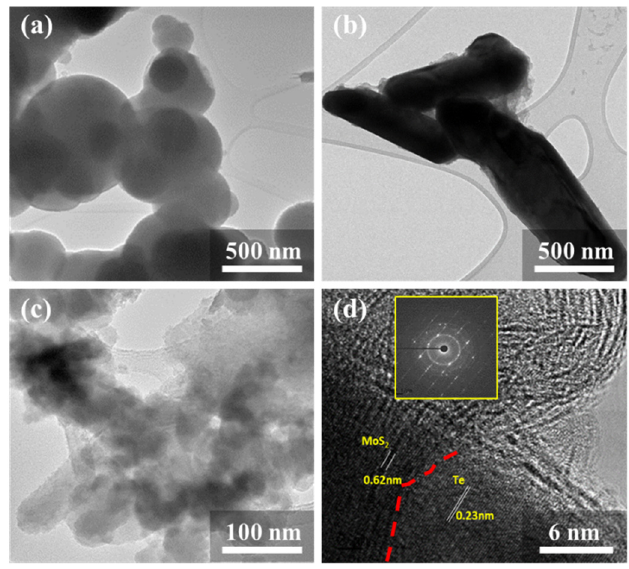
Figure 2. TEM images of: ( a ) Pure MoS 2 , ( b ) pure Te nanorods, and ( c,d ) MoS 2 /Te.